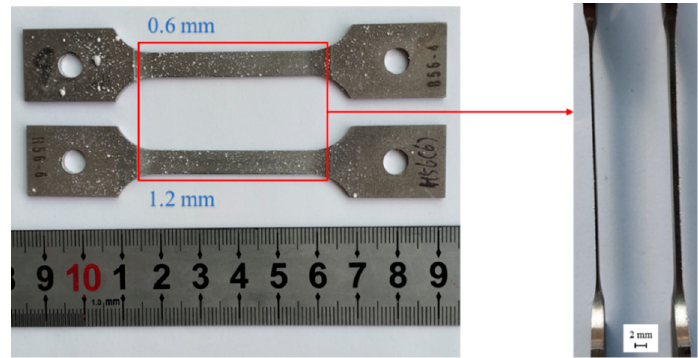
Figure 4. Photo of creep specimens with thickness of 0.6 mm and 1.2 mm after